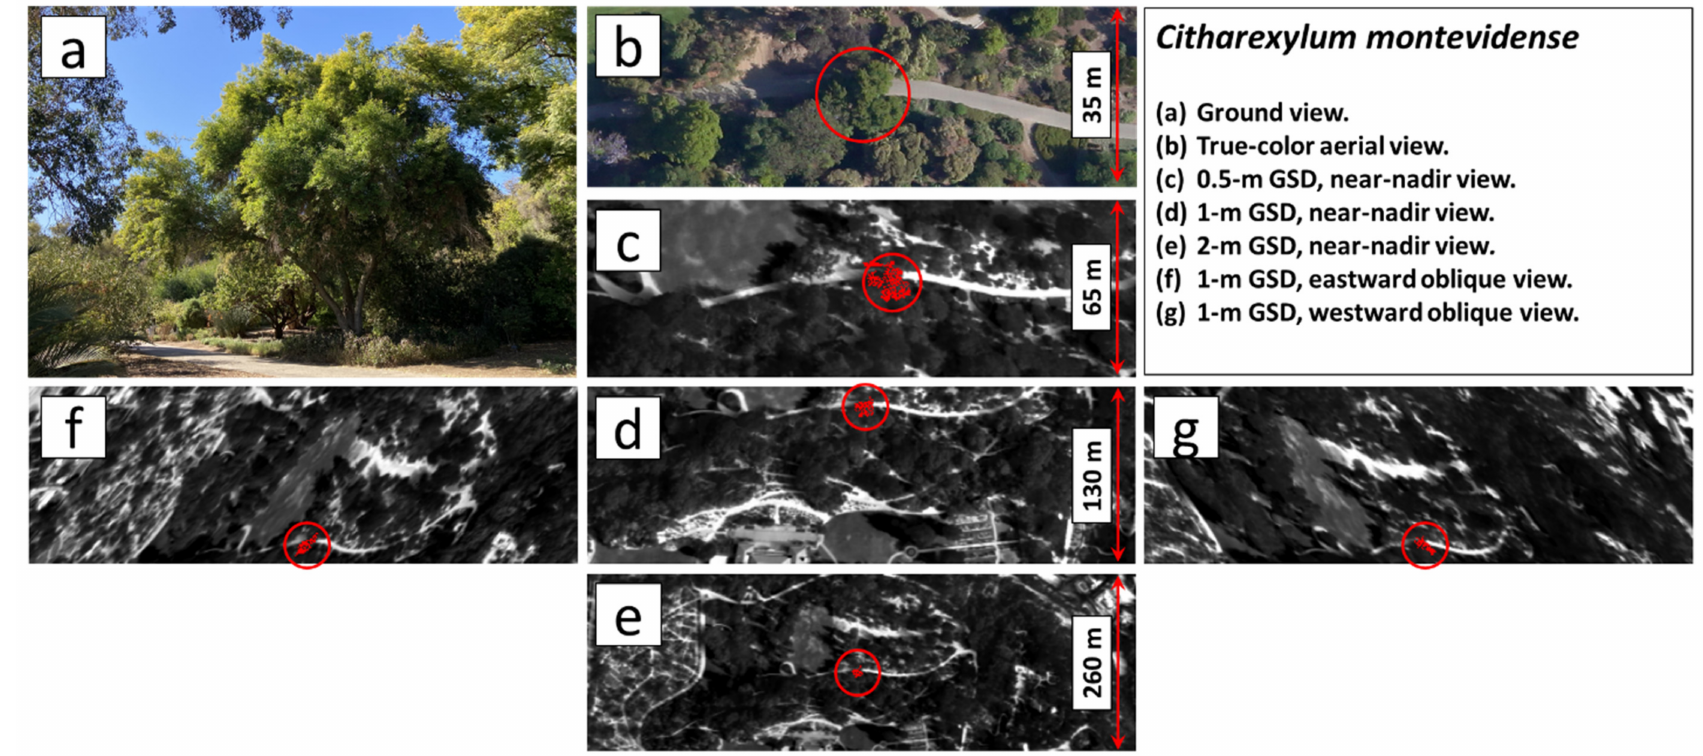
Figure 5. Citharexylum montevidense ID as a function of GSD and observation angle: ( a ) ground view of target tree, ( b ) true-color aerial image, ( c ) thermal scene image at 0.5-m GSD with target ROI overlay (red), ( d ) thermal scene image at 1-m GSD with target ROI overlay (red), ( e ) thermal scene image at 2-m GSD with target ROI overlay (red), ( f ) eastward-looking oblique thermal scene image at 1-m GSD with target ROI overlay (red), ( g ) westward-looking oblique thermal scene image at 1-m GSD with target ROI overlay